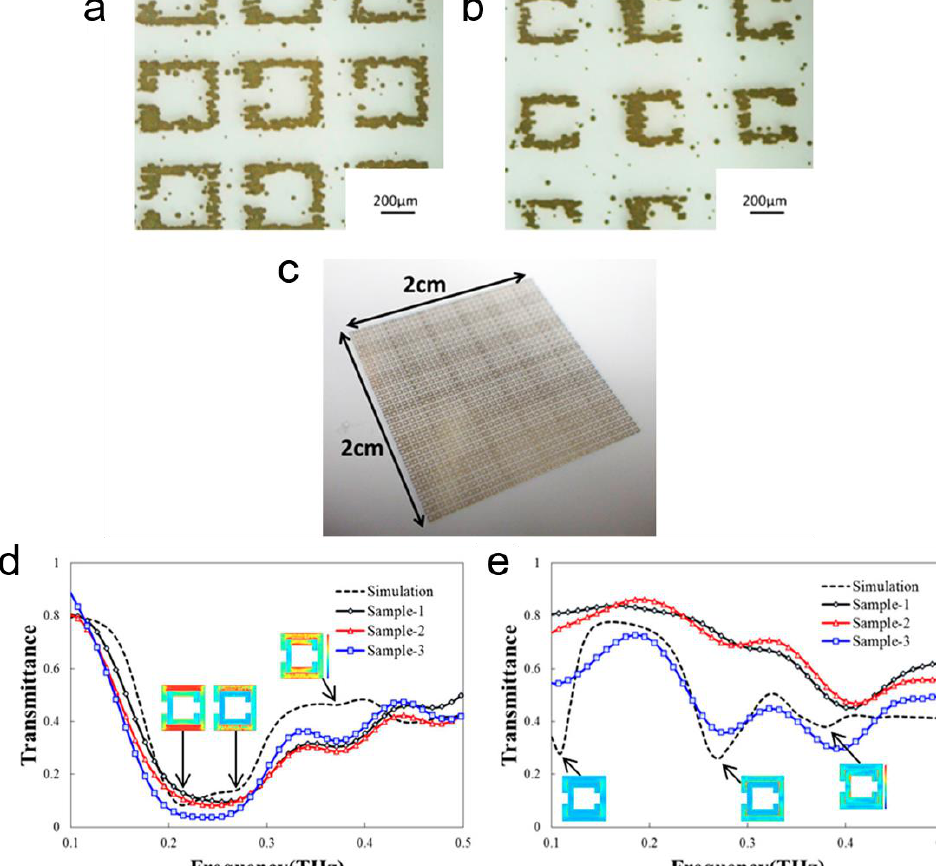
Figure 1. A THz Split ring resonator (SRR) fabricated by inkjet printing of silver nanoparticles. ( a ) Upper SRR array, ( b ) lower SRR array and ( c ) an overall view of the fabricated sensor. Transmission spectra of the stacked SRR arrays for ( d ) x- and ( e ) y-polarised incident waves. Insets in ( d , e ) represent simulated TE-modes at resonance frequencies [57]. © 2018, AIP Advance.